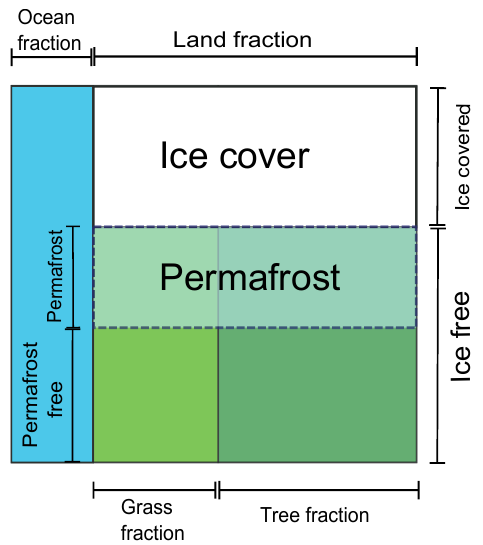
Figure 1. A CLIMBER-2P grid cell showing the distribution of dif- ferent cell cover